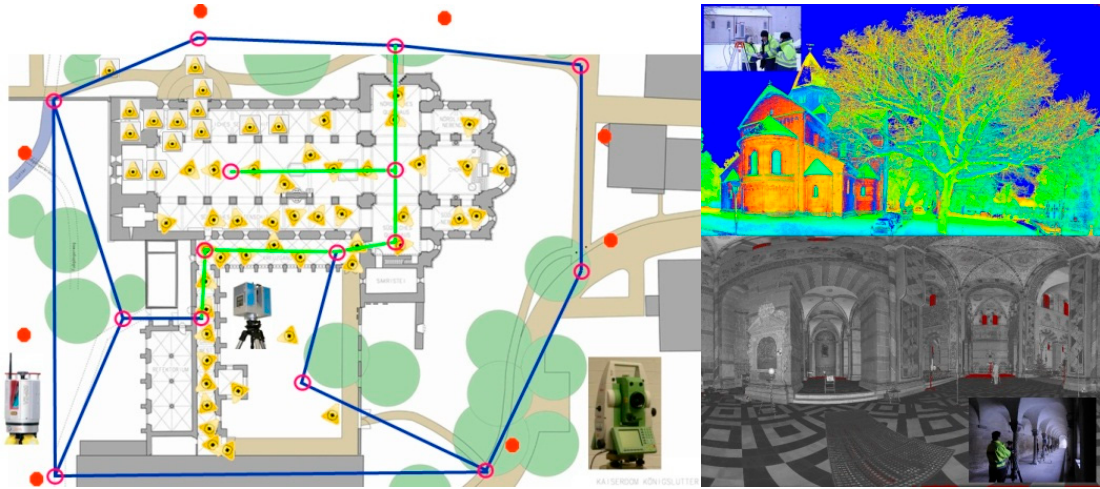
Figure 3. Geodetic 3D network (blue and green lines) and position of the scan stations (IMAGER 5006 = yellow triangles, Riegl VZ-400 = red dots) at the cathedral ( left ), Riegl VZ-400 point cloud of ( top right ) and 2D presentation of an IMAGER 5006 scan ( bottom right ).